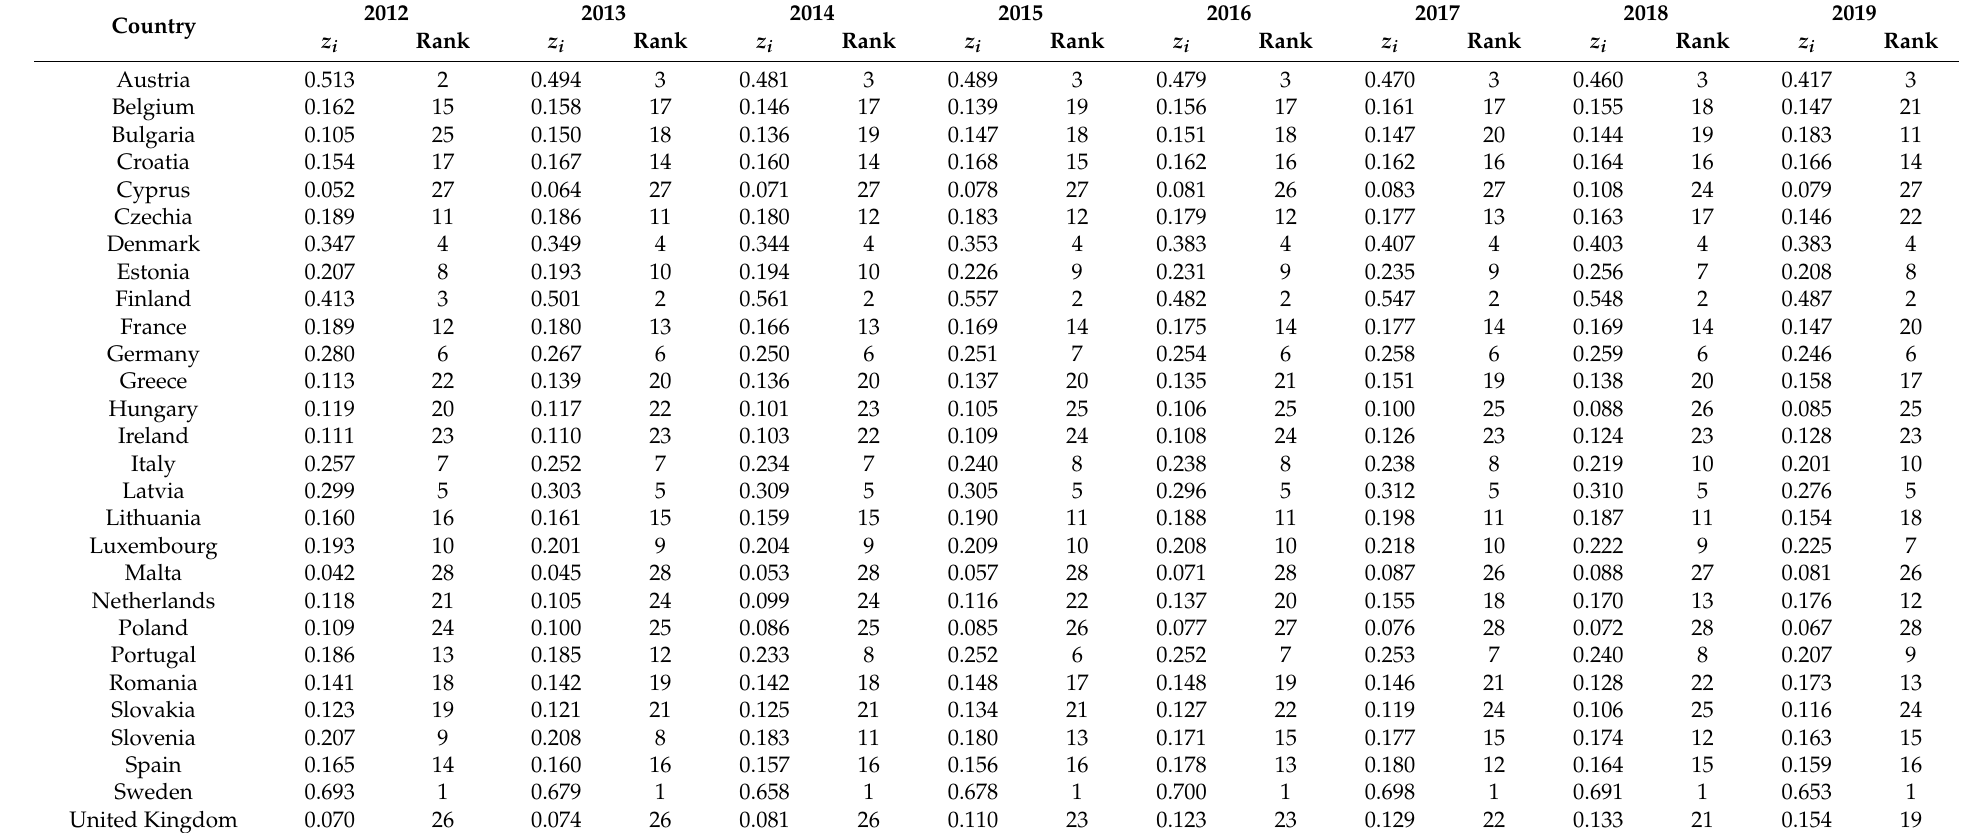
Table A2. The EU countries sorted by using renewable energy sources in: